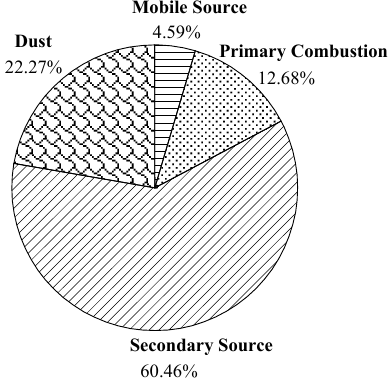
Figure 12. The source contribution rate from the PMF model.